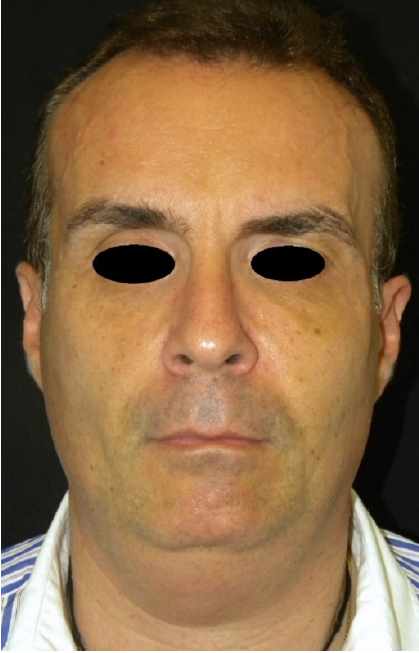
Figure 5. Frontal view of a patient presenting facial wasting and submental fullness (the same patient shown in Figure 4) treated with CaHA injection, at 3 months follow-up.